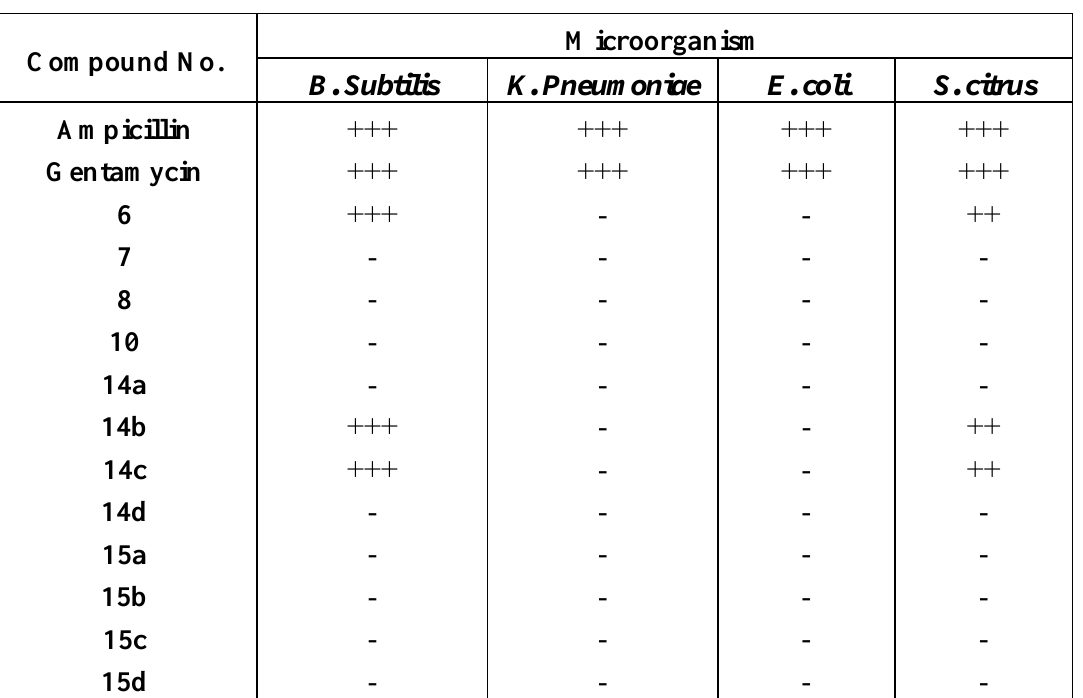
Table 1 . Results of antimicrobial activity tests of the synthetic monocyclic and bicyclic β